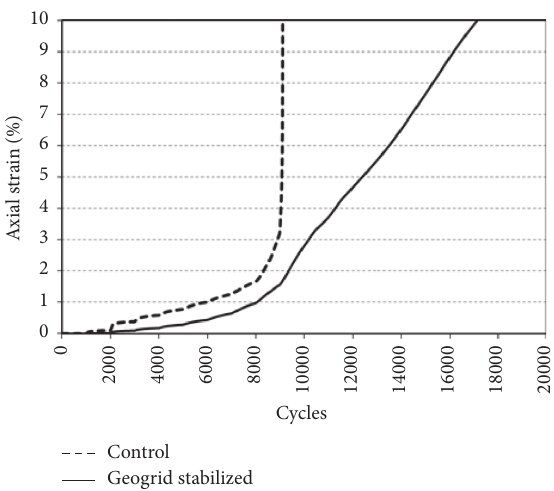
Figure 5: Repeated load permanent deformation from NCHRP 598 test (uncured samples).